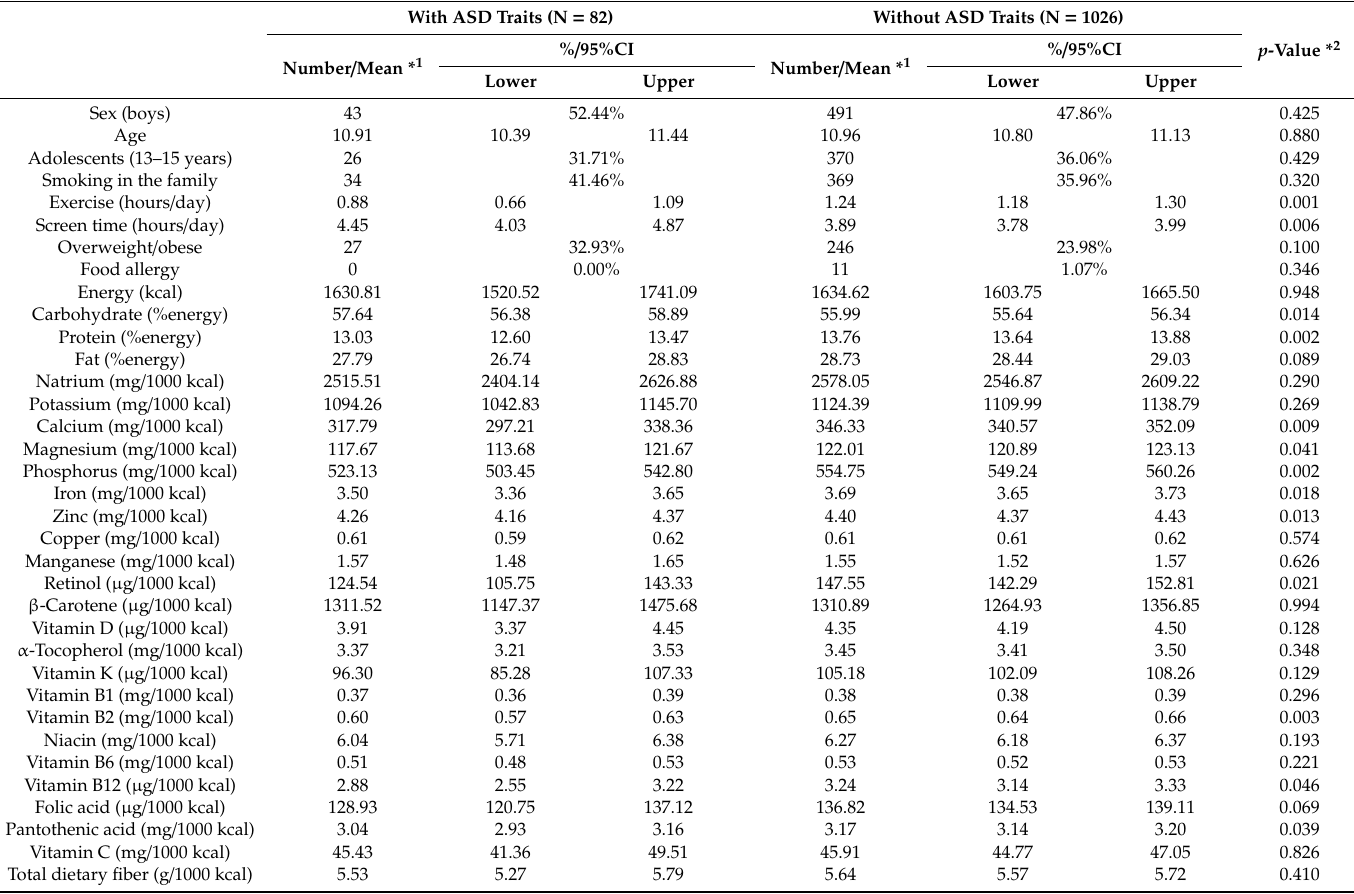
Table 2. Comparisons of the characteristics and nutrient intakes between participants with and without ASD